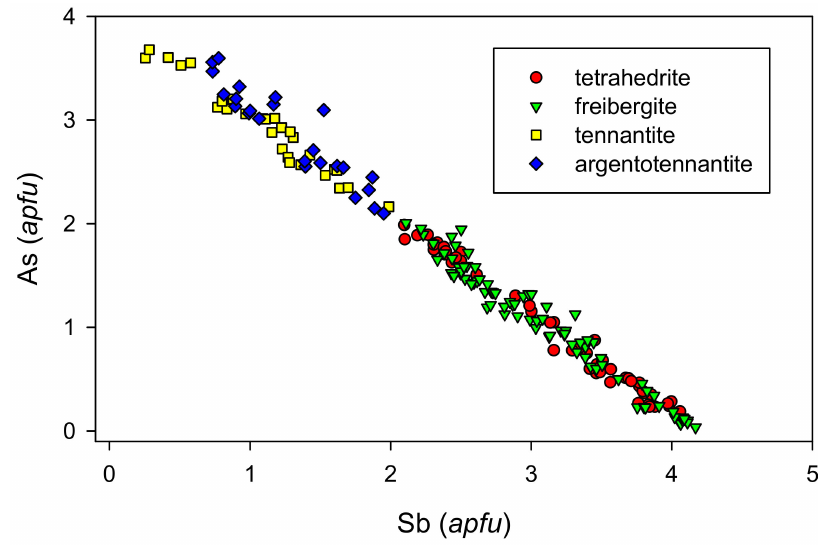
Figure 16. Graph of Sb vs. As ( apfu ) for members of the tetrahedrite group from the Kremnica deposit.